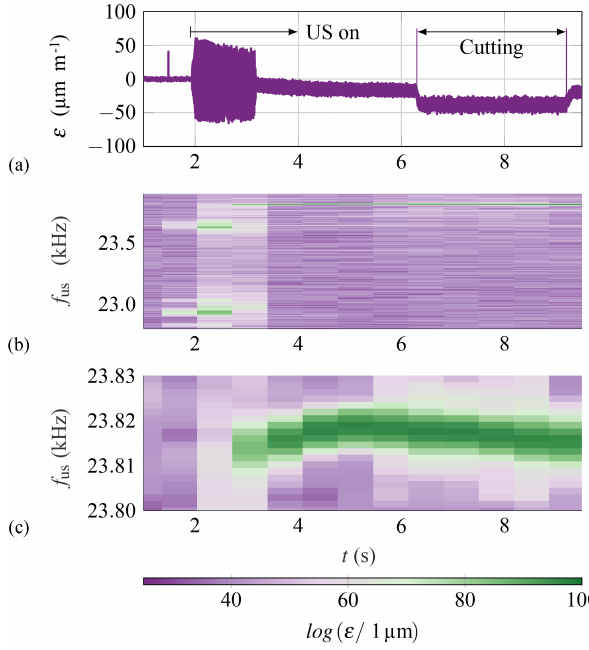
Figure 5. The strain ( ε ) detected by SG 3 (a) of the sample pro- cessed using UVA, the resulting FFT (b) and a magnification at the frequency range from 23.8 to 23.83kHz (c)